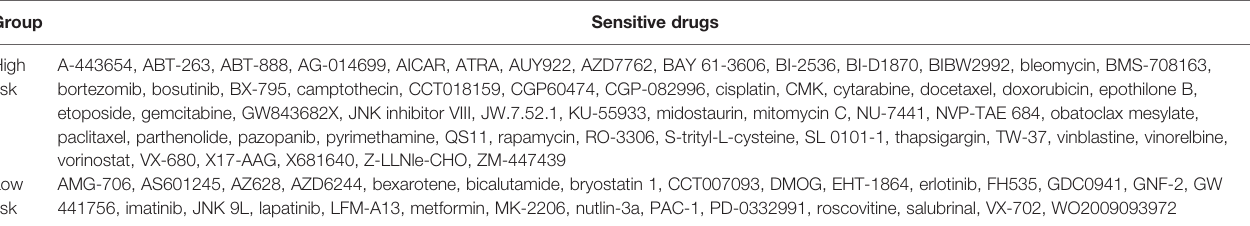
TABLE 2 | The sensitive chemotherapeutic and small molecule drugs in the high- and low-risk groups. Group Sensitive drugs High